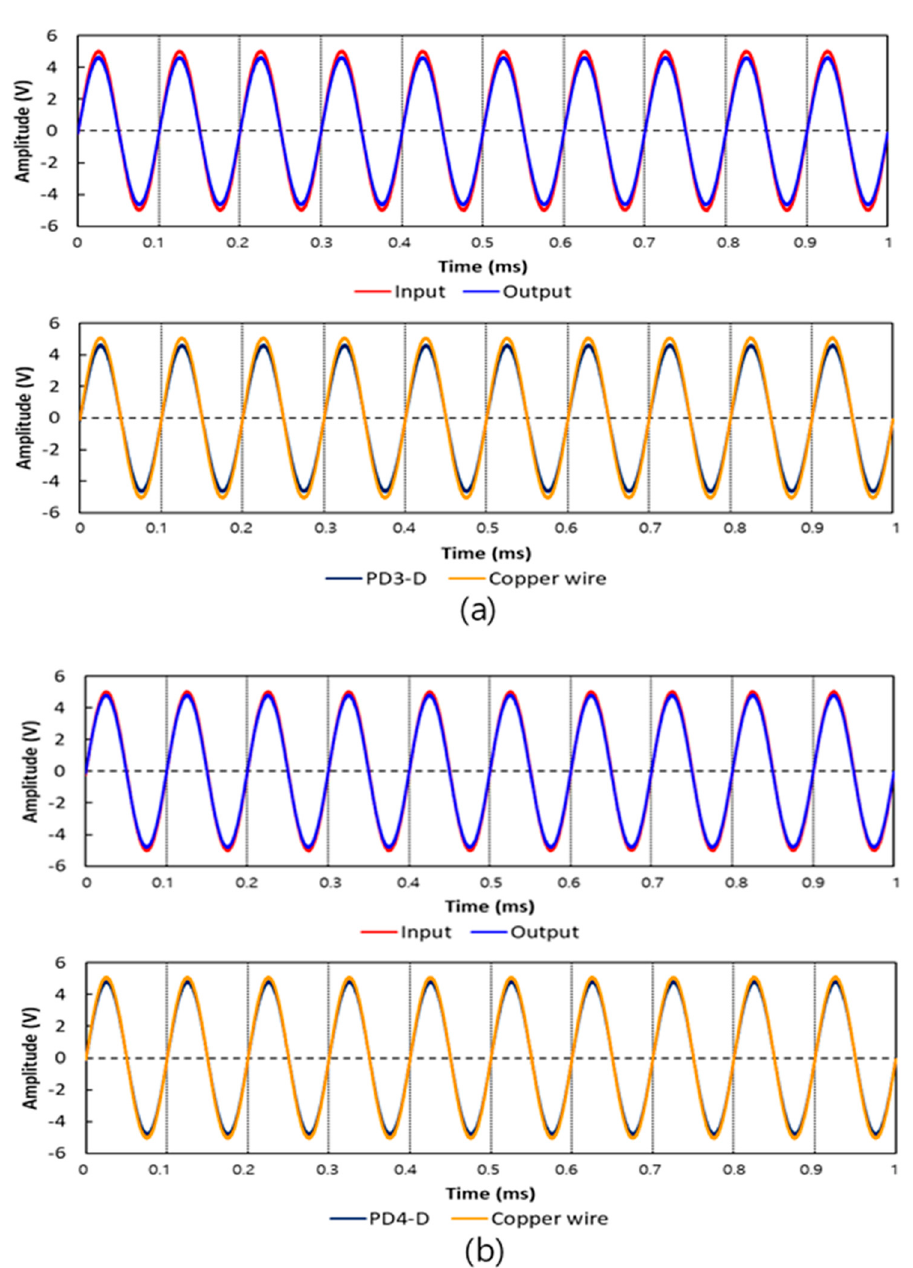
Figure A1. Comparison of waveforms between the input signal and output signal of the samples, and comparison of waveforms between copper wire and the sample ( a ) PD3-D, ( b ) PD4-D.